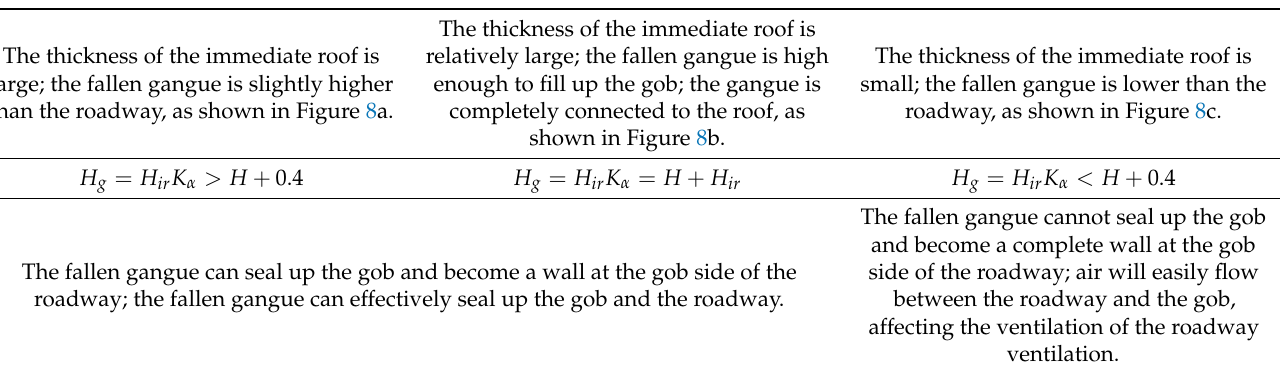
Table 2. Determination of the wall formability of gangue [40].